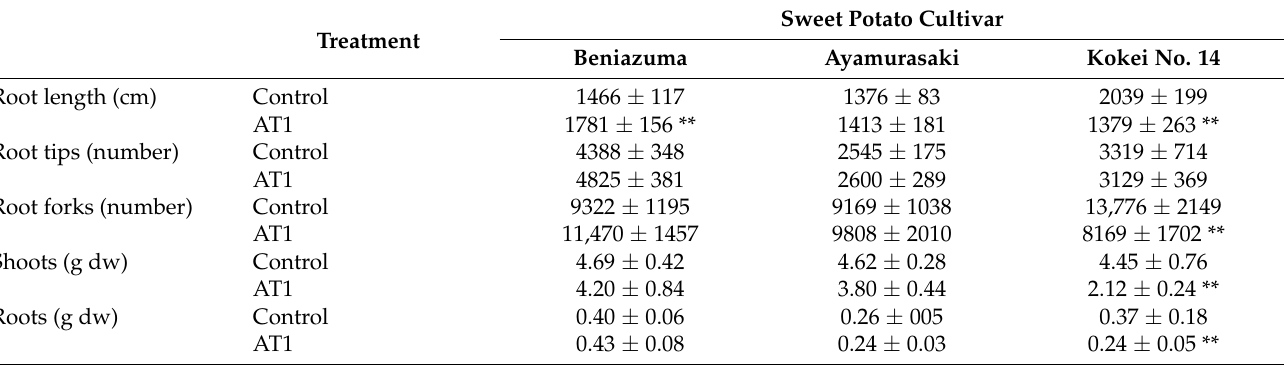
Table 2. Effects of Bradyrhizobium sp. AT1 inoculation on root development and shoot growth of three cultivars of sweet potato grown in pots *.